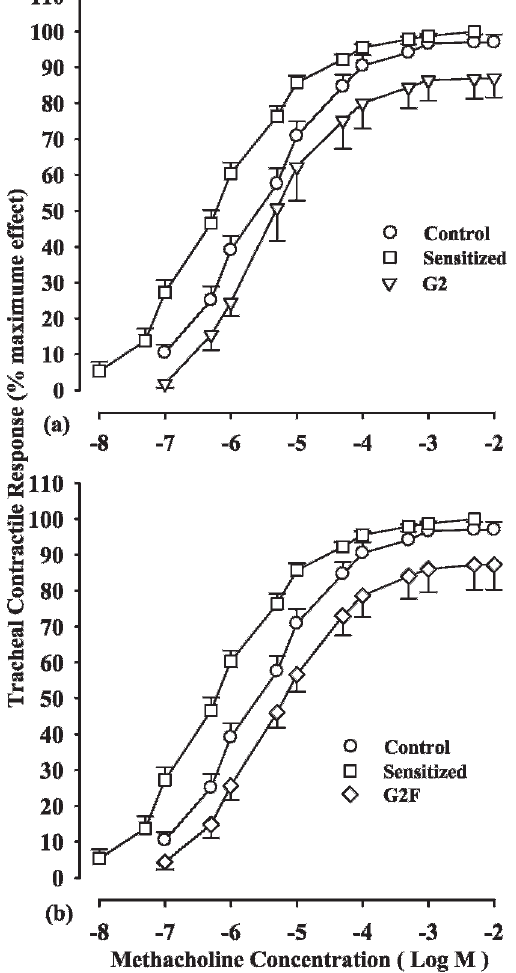
Figure 1 - Cumulative log concentration-response curves of methacholine-induced contraction of the isolated trachea in the control (C), sensitized (S), S treated with adjuvant G2 (S + G2) and S treated with adjuvant G2F (S + G2F) guinea pigs (for each